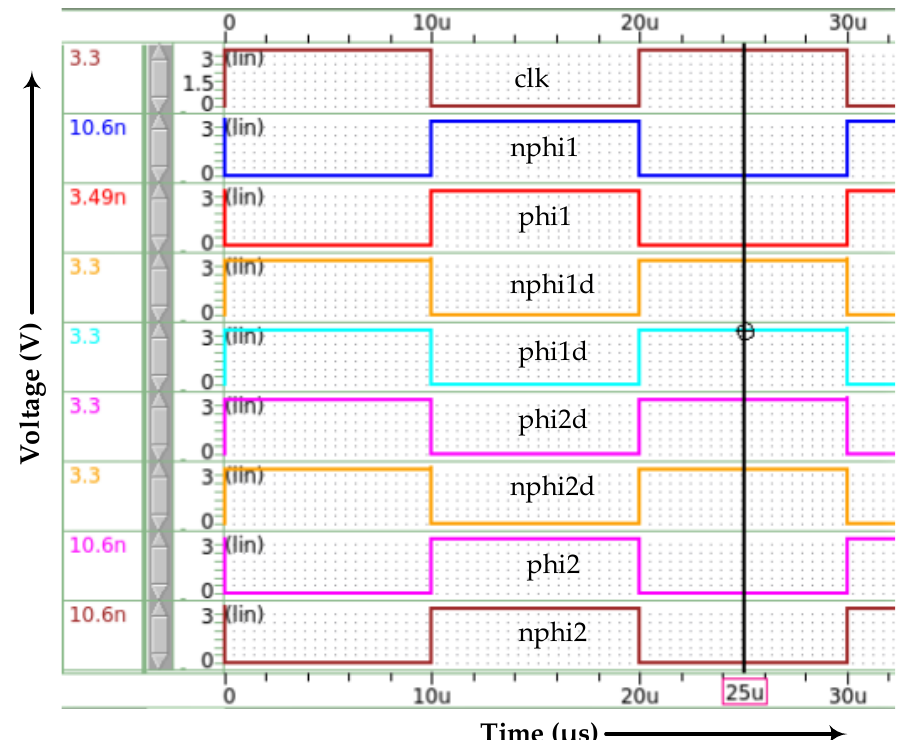
Figure 7. Non-overlapping clock circuit simulation graph.